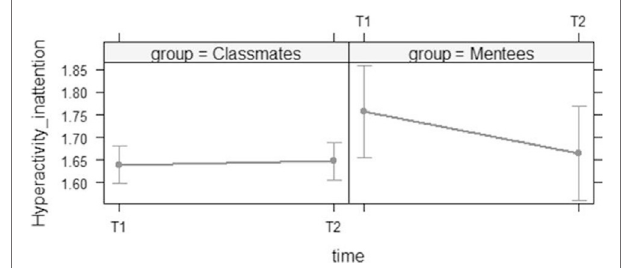
FIGURE 1 | Means of hyperactivity/inattention by Time and